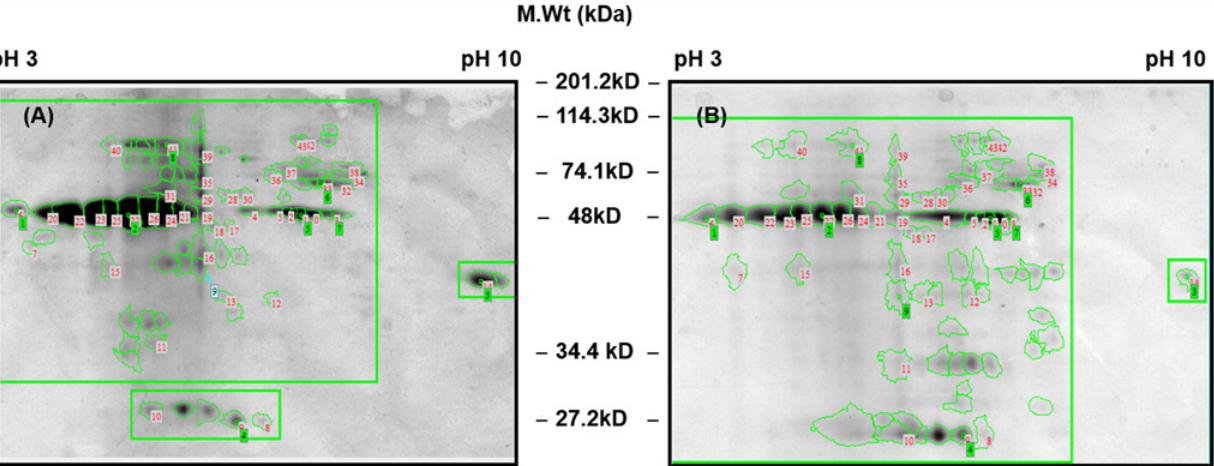
Fig 1. Representative 2D gel picture of An . stephensi salivary gland proteins. Molecular weight (kDa) is shown in the middle of gel. (A) Silver-stained gel of An . stephensi susceptible strain numbered from 1 to 43 using ImageMaster 2D Platinum 7.0 software (B) Silver-stained gel of An . stephensi multi resistant strain numbered from 1 to 43 using ImageMaster 2D Platinum 7.0